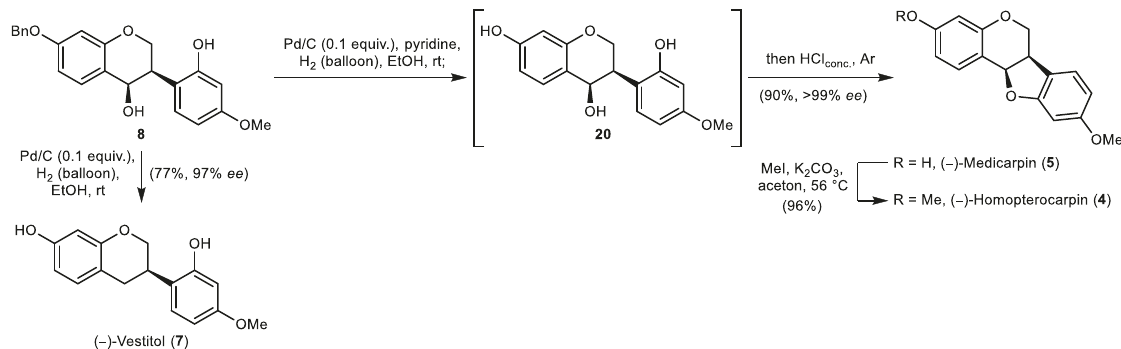
Fig. 4 Final steps of the synthesis of several natural iso fl avonoids. Reduction to ( − )-vestitol ( 7 ), construction of the pterocarpan skeleton, and methylation to ( − )-homopterocarpin ( 4